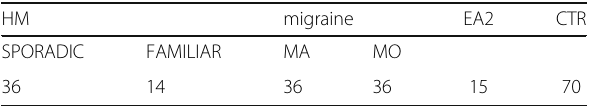
Table 1 Baseline